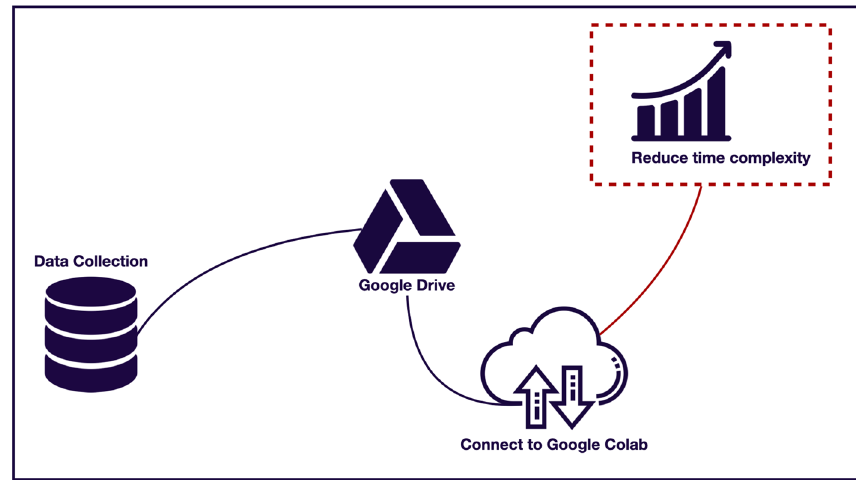
Fig. 3 Steps to reduce the time complexity of training ML